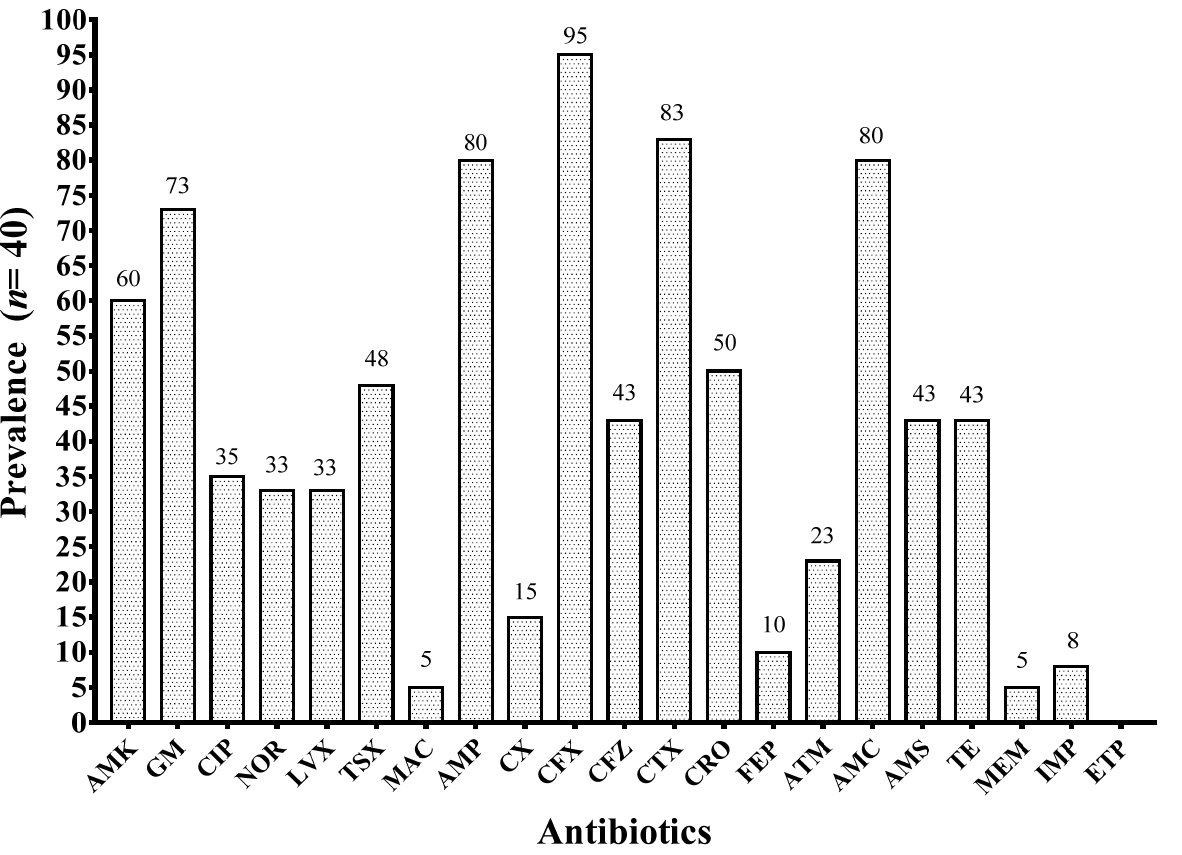
Figure 5. Antibiotic resistance prevalence. AMK : Amikacin; GM : Gentamicin; CIP : Ciprofloxacin; NOR : Norfloxacin; LVX : Levofloxacin; TSX : Cotrimoxazole; MAC : Nitrofurantoin; AMP : Ampicillin; CX : Cefoxitin; CFX : Cefuroxime; CFZ : Ceftazidime; CTX : Cefotaxime; CRO : Ceftriaxone; FEP : Cefepime; ATM : Aztreonam; AMC : Amoxicillin/Clavulanate; AMS : Ampicillin/Sulbactam; TE : Tetracyclin; MEM : Meropenem; IMP : Imipenem; ETP :